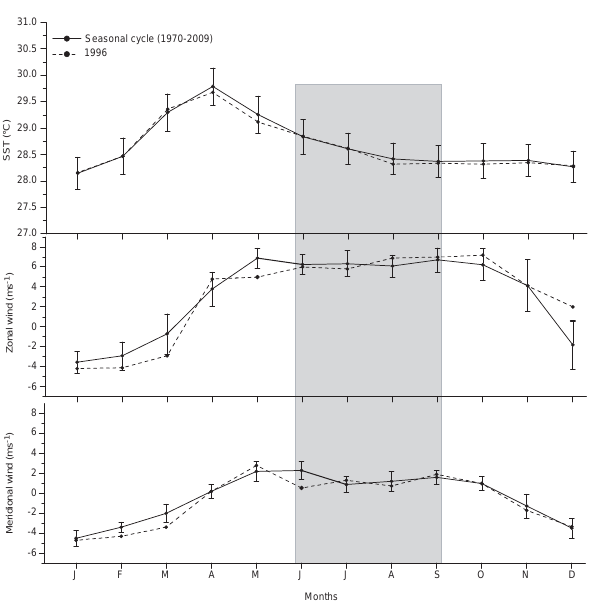
Fig. 2. Climatological monthly mean during the period 1970–2009 (thick line), and monthly mean of 1996 (dotted line) of SST (up- per panel), zonal wind (middle panel) and meridional wind (bot- tom panel). Shading represents the summer monsoon period (June– September) and vertical lines are one standard deviation.